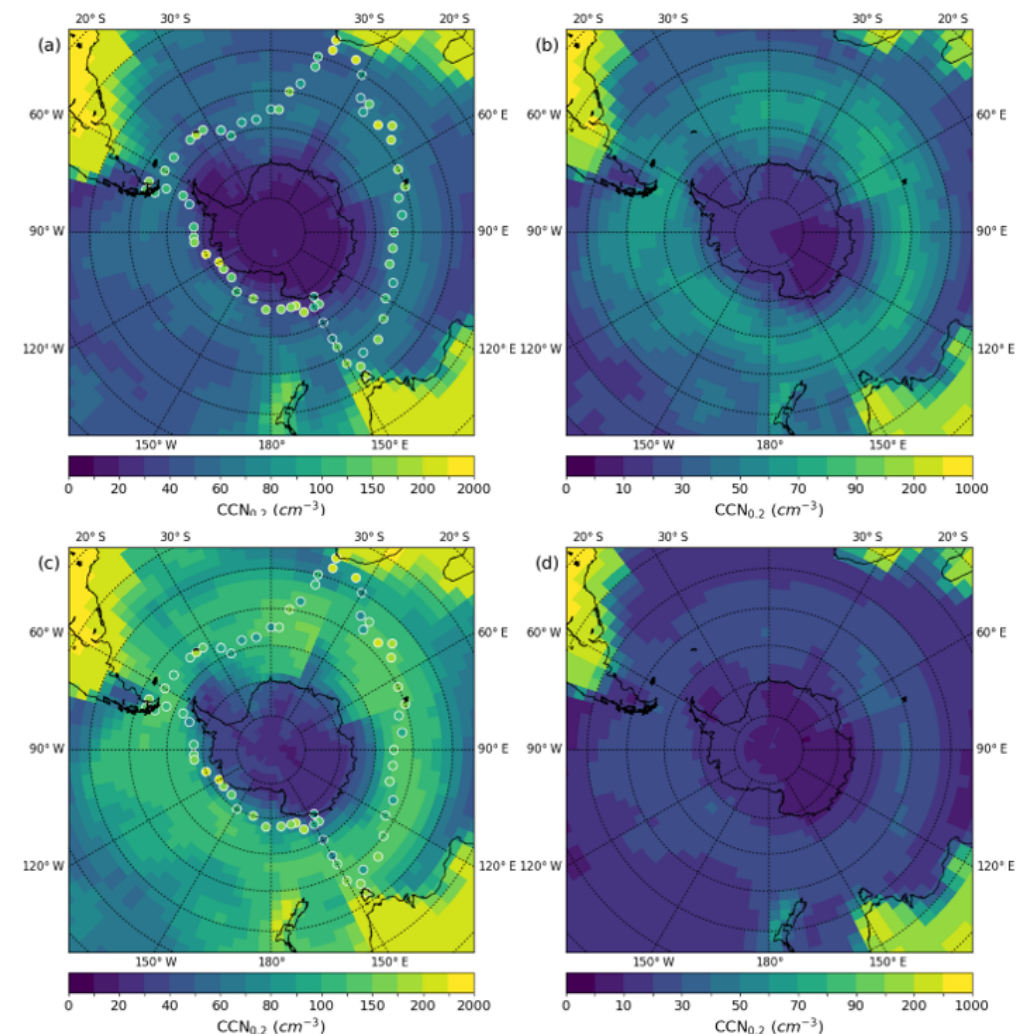
Figure 1. (a, c) Mean and (b, d) standard deviation of CCN 0 . 2 concentrations from the (a, b) unconstrained sample and (c, d) the sample constrained using concentration measurements of CCN 0 . 2 , CCN 1 . 0 , non-sea-salt sulfate and particles with dry aerodynamic diameters larger than 700nm. Measured CCN 0 . 2 values are plotted as dots. Means and standard deviations were calculated using samples taken from emulators trained using monthly mean values. December to March sample values were combined based on longitudinal agreement with